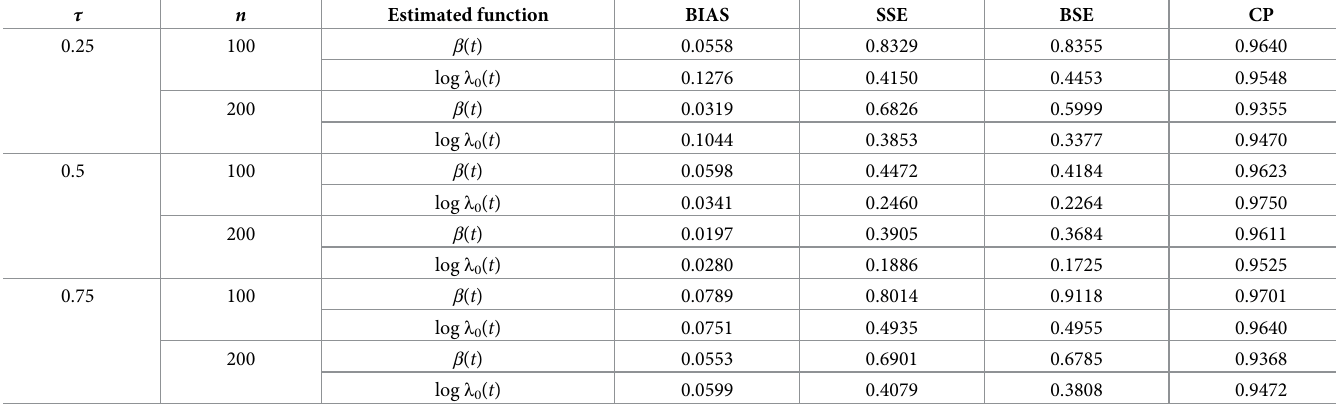
Table 1. BIAS, SSE, BSE and CP of the estimated functions in Case I at different τ . τ